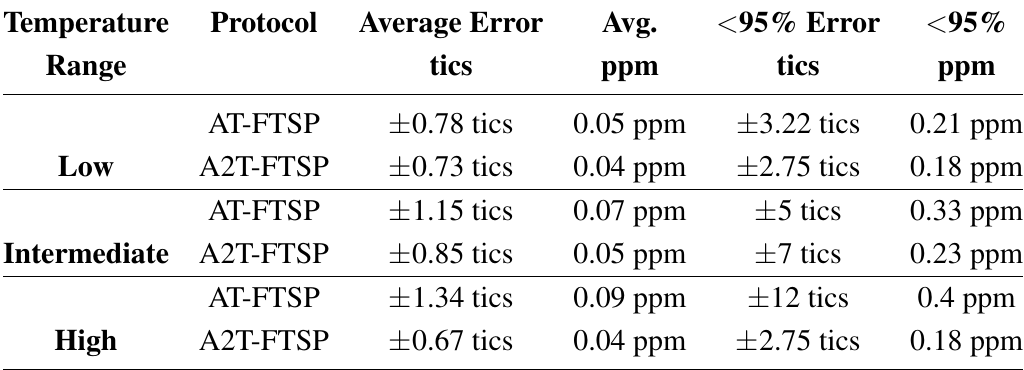
Table 6. General results.